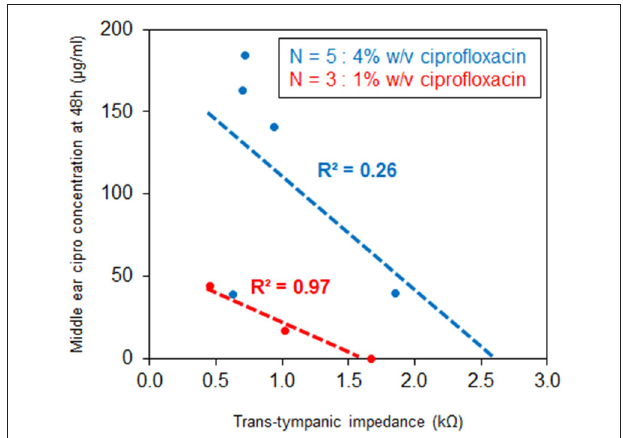
FIGURE 6 | Correlation between trans-tympanic impedance and middle ear ciprofloxacin concentration at